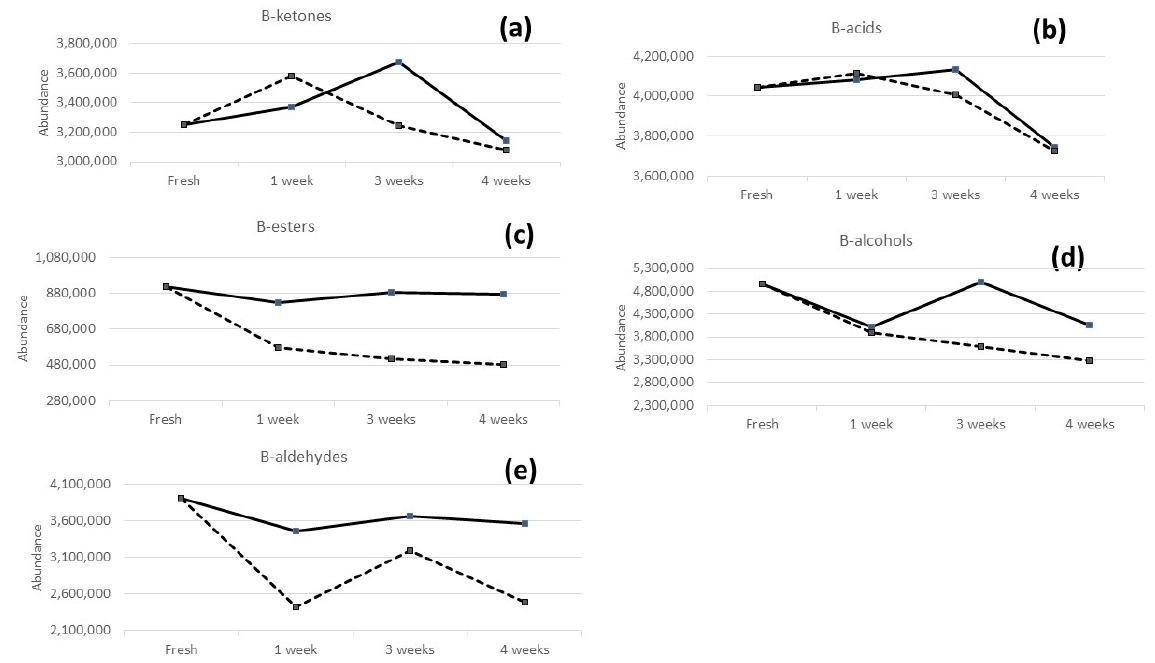
Figure 3. Evolution of the main groups of volatile compounds, namely ketones ( a ), acids ( b ), esters ( c ), alcohols ( d ), and aldehydes ( e ), in B bread samples stored in refrigerator (solid line) and in the freezer (dashed line).